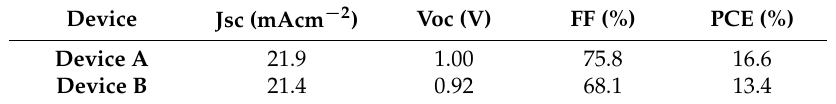
Table 4. The photovoltaic performance of Device A and B deposited using different techniques.